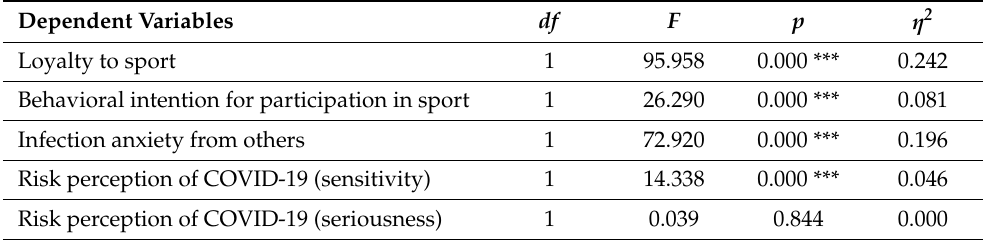
Table 3. Results of one-way multivariate analysis of variance.